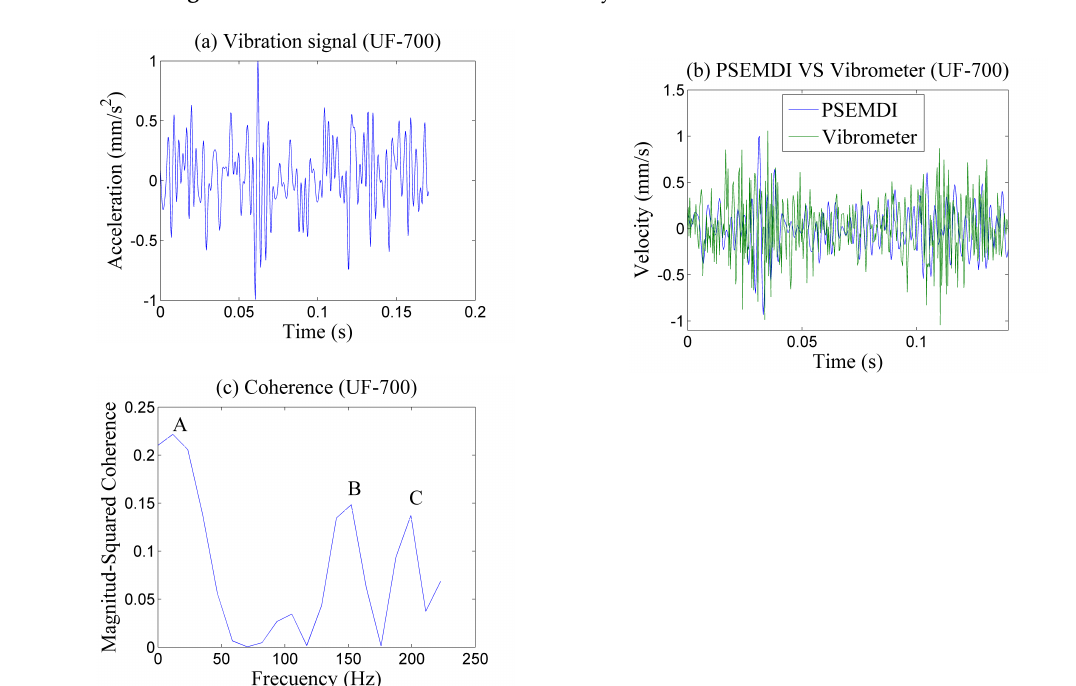
Figure 9. IMFs obtained from acceleration by EMD.